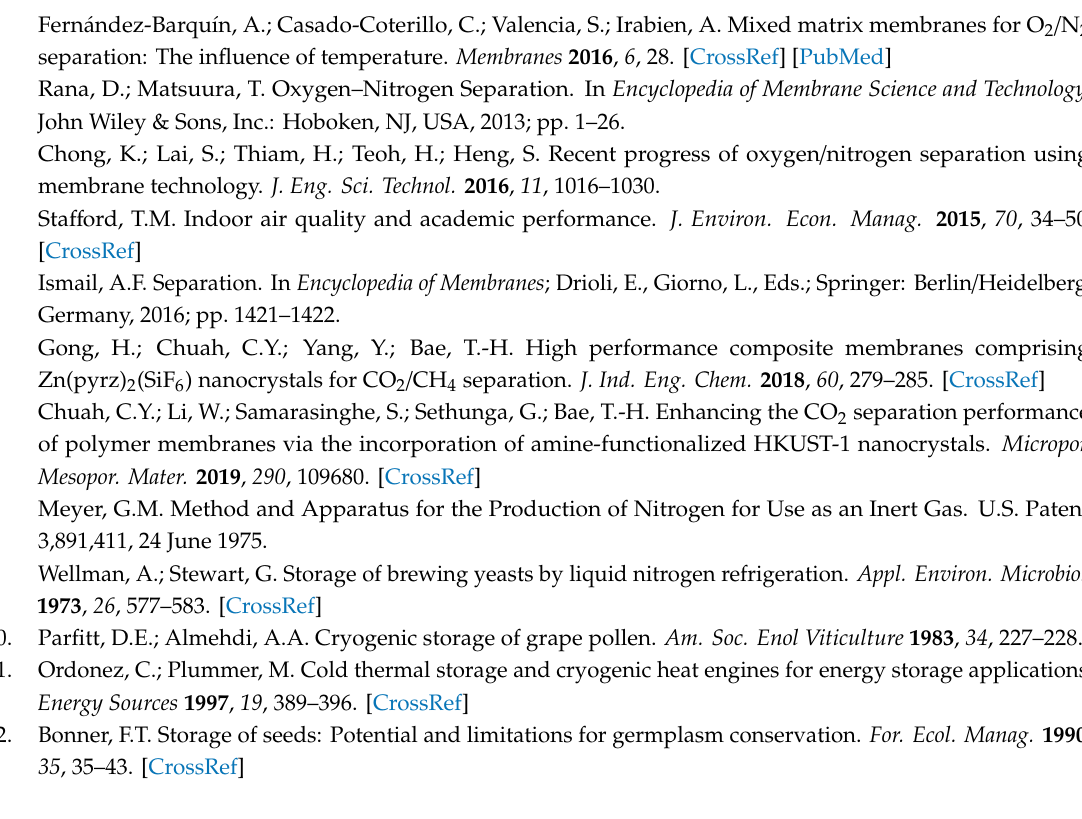
Figure S1: Characterization of the facilitated carrier (CoPCMP) and compatibilizer (Pluronic) by (a) FTIR; (b) powder XRD; (c) TGA, and (d) DTA analysis (for the case of Pluronic, due to its onset of degradation occurs around 200 ◦ C; thus the DTA curve beyond 200 ◦ C is indicated as dotted line). Figure S2: N 2 sorption for CoPCMP at 77 K. Figure S3: (a) TGA and (b) TDA of neat (Matrimid), blended (Matrimid-Pluronic), and composite (Matrimid-CoPCMP and Matrimid-Pluronic-CoPCMP) membranes. Figure S4: Cross-sectional FESEM image of Matrimid-CoPCMP (10 wt.%) under (a) low magnification; (b) high magnification. Figure S5: Comparison of the membrane performance (in Table 1) with the upper bound limit (1991, 2008, 2015). Figure S6: EDX mapping of 5 wt.% CoPCMP and 10 wt.% Pluronic in Matrimid membranes. Figure S7: Solubility and di ff usivity selectivity of the studied membranes. Table S1: Porosity properties of CoPCMP. Table S2: Mechanical test of neat (Matrimid) and blended (Matrimid-Pluronic)